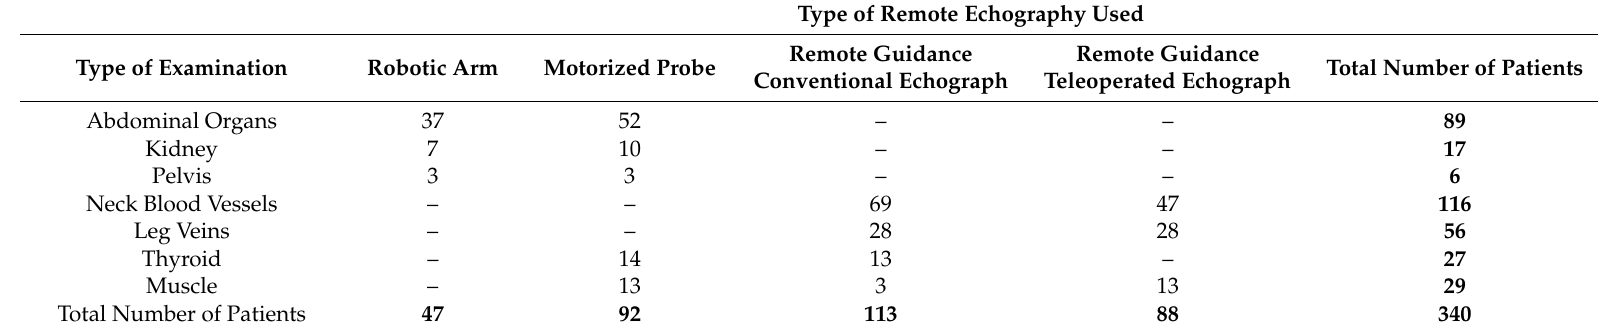
Table 1. Number and type of examinations performed with each method of remote echography.